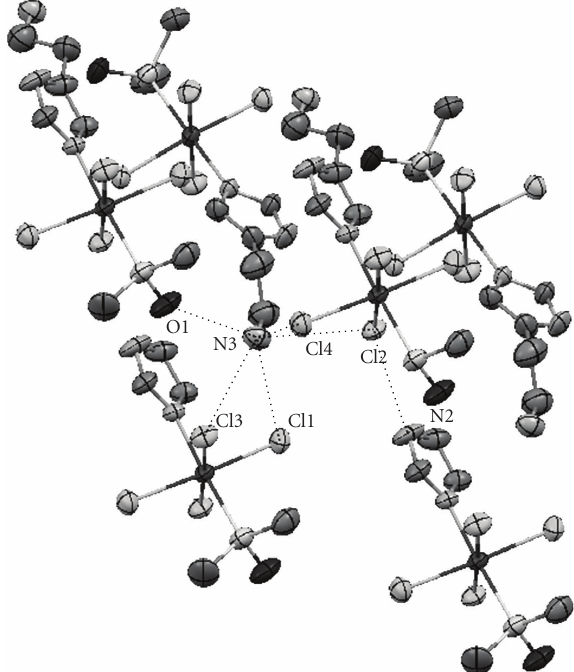
Figure 2: The hydrogen bonds in the crystal structure of compound 1b . The ammonioethyl groups of the lower two asymmetric units are omitted for